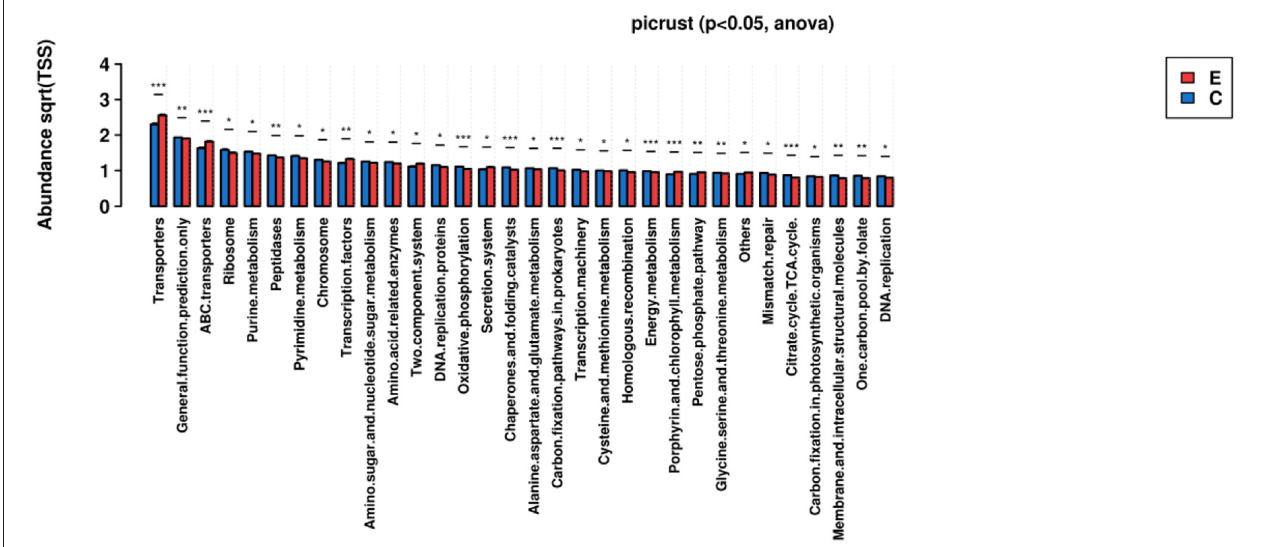
FIGURE 5 | KEGG Ortholog functional profiles of microbial communities were predicted by PICRUSt (* p < 0.05, ** p < 0.01, *** p < 0.001).